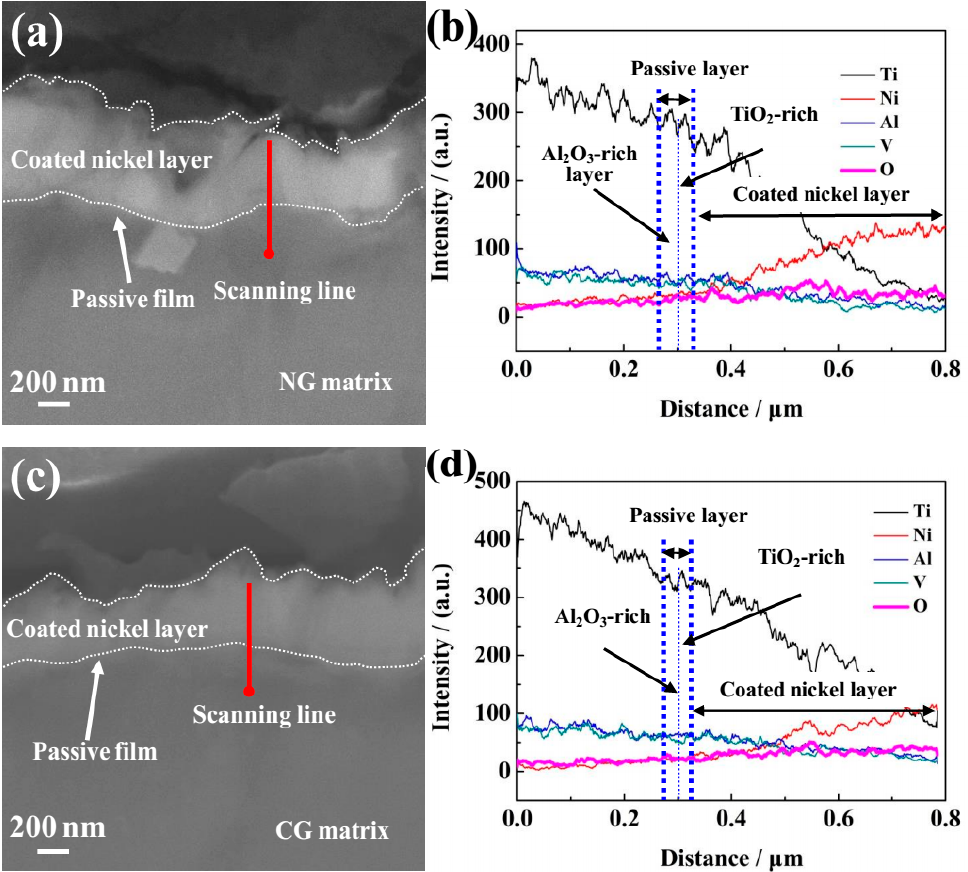
Figure 5. Cross-sectional SEM observations of passive films formed on NG (a) and CG (c) Ti–6Al–4V alloys after potentiodynamic polarization. The corresponding energy-dispersive spectrometer (EDS) analyses for NG ( b ) and CG ( d ) alloys correspond to red lines are shown in ( a ) and ( c ).